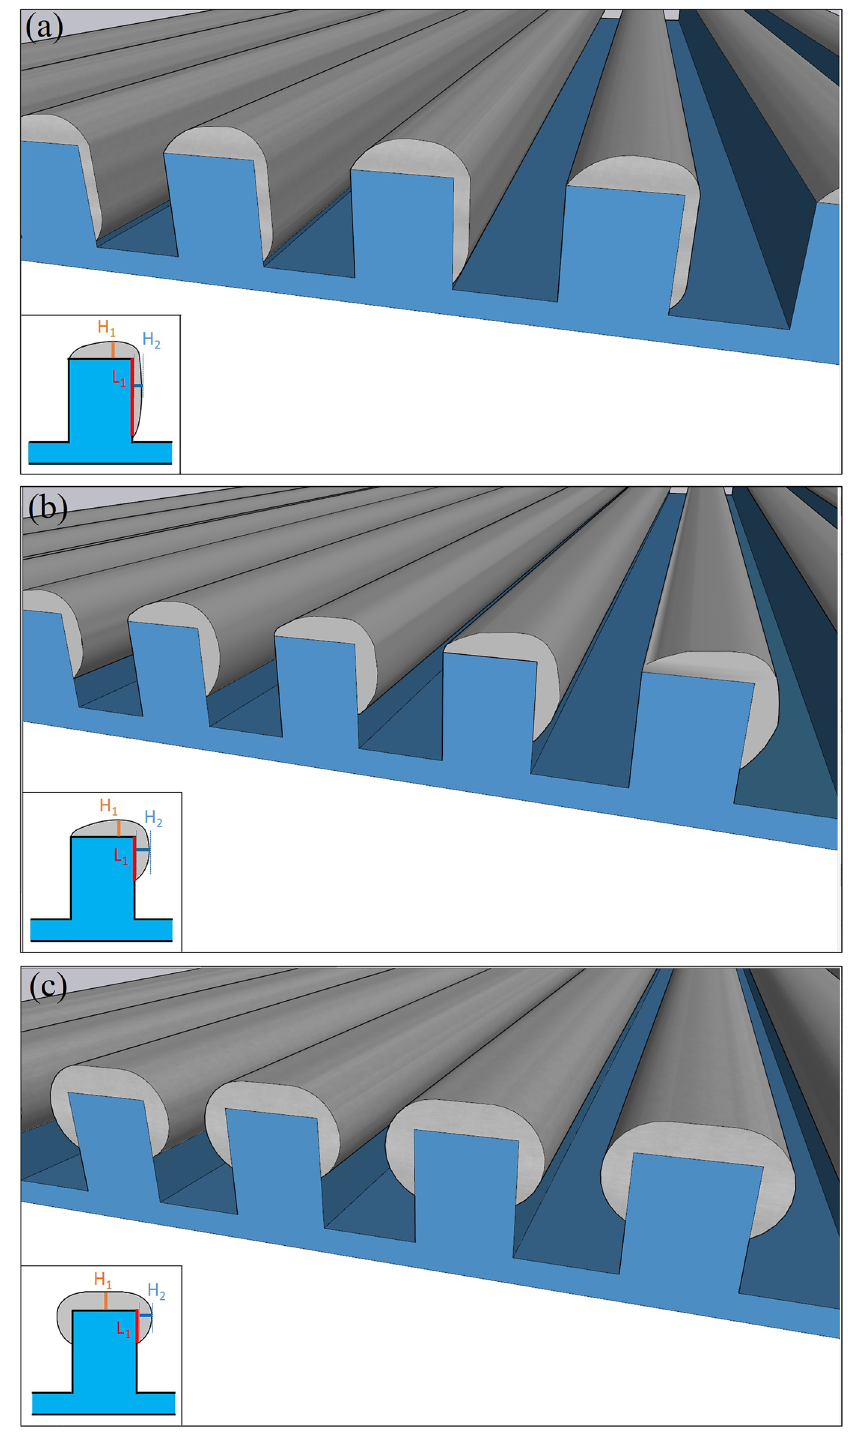
Figure 2. Schematic-drawings of silver coated on gratings: ( a ) SNTA-1, ( b ) SNTA-2, ( c )